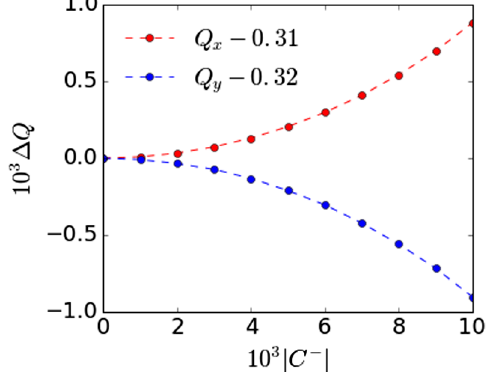
FIG. 4. Initial uncoupled horizontal (red) and vertical (blue) tune shifts required in order to maintain collision tunes.